Question: In one sentence, what is this figure communicating?
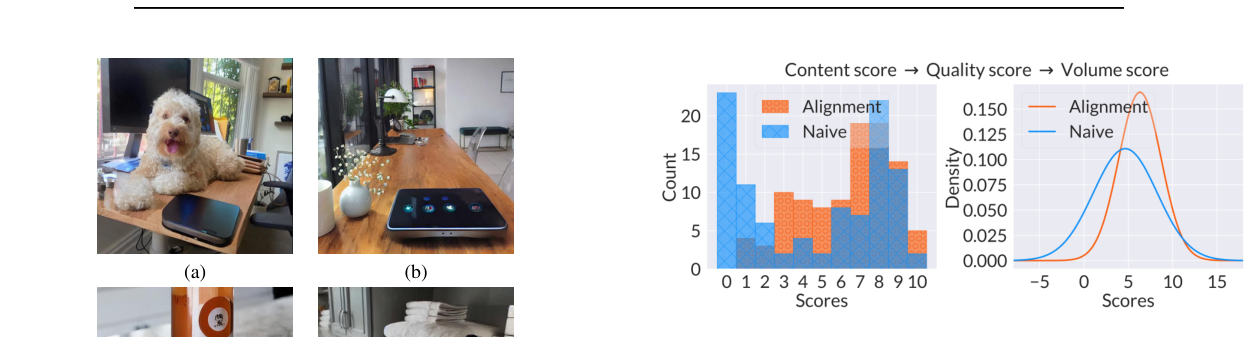
Answer: Empirical performance of Alignment Module for Ama- zon Echo Dot. Noticeably, no output is generated without any product when the Alignment Module is employed. Moreover, the mean quality score has increased from 4.65 to 6.31.